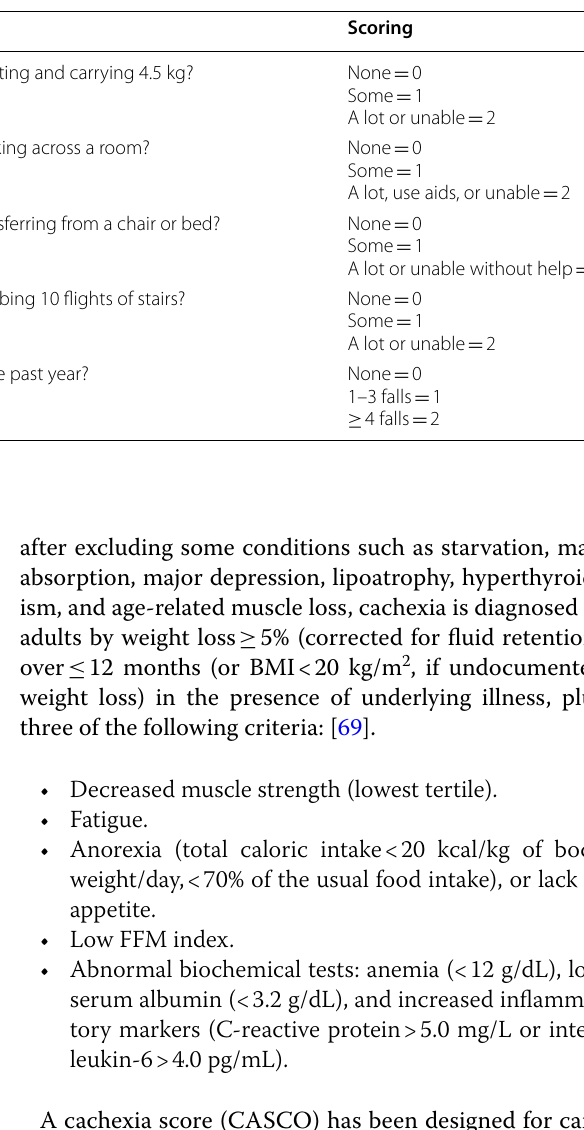
Table 5 SARC‑F questionnaire Component